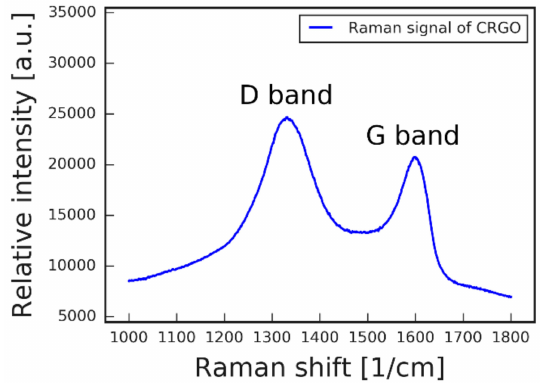
Figure 3. Raman spectrum of CRGO showing the presence of strong D- and G-bands.